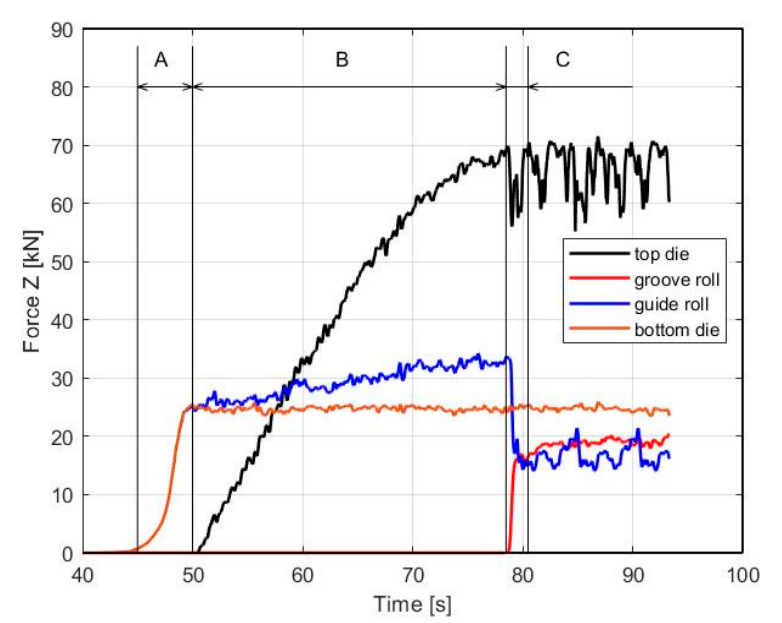
Figure 6. The force load in the Z -axis direction on the guide, grove roll, top, and bottom die during the ECAR processing. The A, B, and C represent deformation zones: A—Shape Rolling, B—Upsetting, and C—SPD.